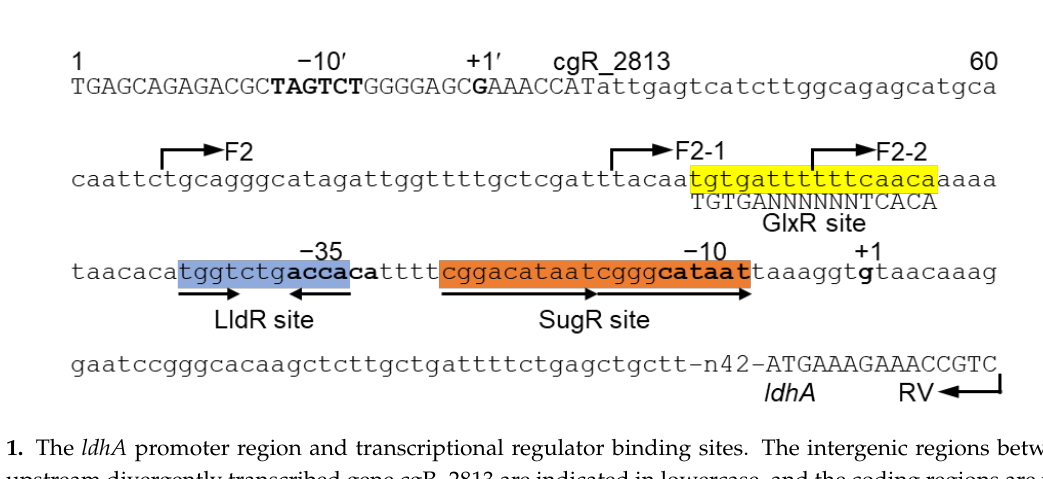
Figure 1. The ldhA promoter region and transcriptional regulator binding sites. The intergenic regions between ldhA and its upstream divergently transcribed gene cgR_2813 are indicated in lowercase, and the coding regions are indicated in uppercase. Bent arrows indicate the 5′ positions of the primers used for the amplification of the promoter region. The transcriptional start site (TSS) of ldhA and the −10 and −35 regions of the ldhA promoter are indicated with bold letters, and their positions with respect to the TSS are indicated in the sequence above. Transcription factor binding sites are highlighted with direct or inverted repeat sequences indicated by arrows. The putative alternative promoter with the TSS detected by RNA sequencing is indicated as +1′. The −10 region of the alternative promoter is indicated as −10′.